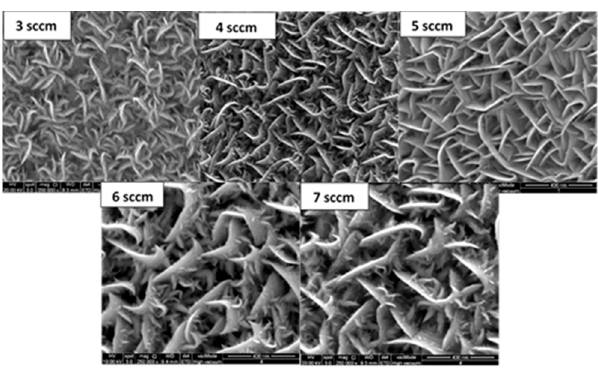
Figure 9. Top view of deposited WS 2 films under different gas flow rates .